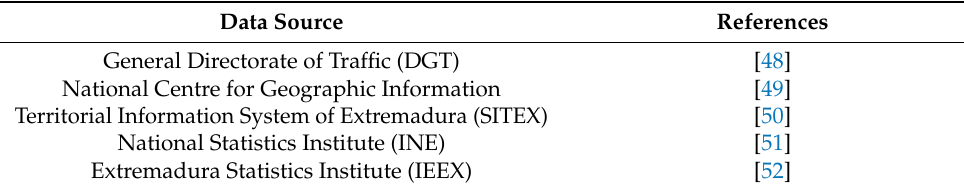
Table 1. Data sources for the study.